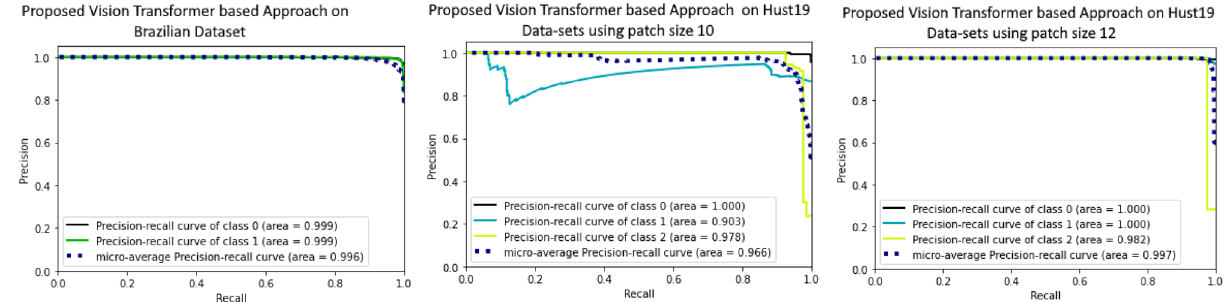
Figure 5. Performance evaluation of proposed vision transformer based approach ( a ): results on Brazilian dataset ( b ) results on Hust19 Data-sets using patch size 10 ( c ) results on Hust19 Data-sets using patch size 12.